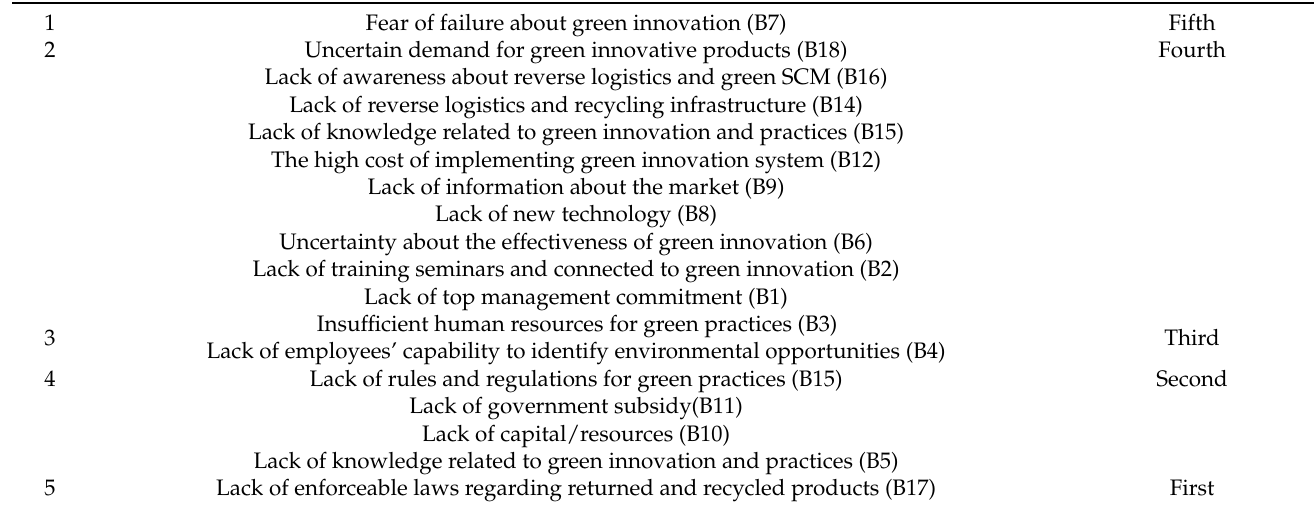
Table 6. Hierarchal levels and barriers at each